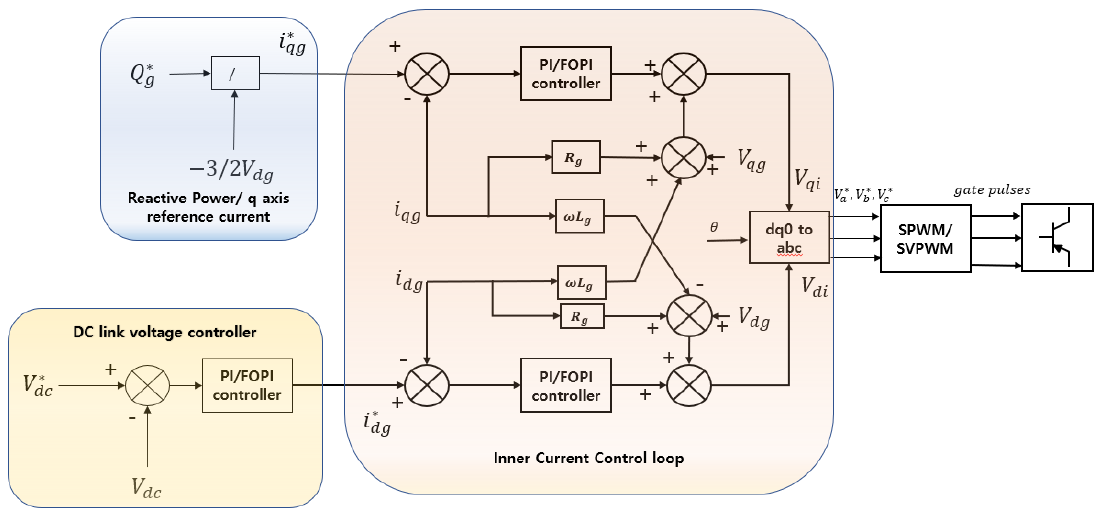
Figure 4. Outer voltage and inner current control loops.